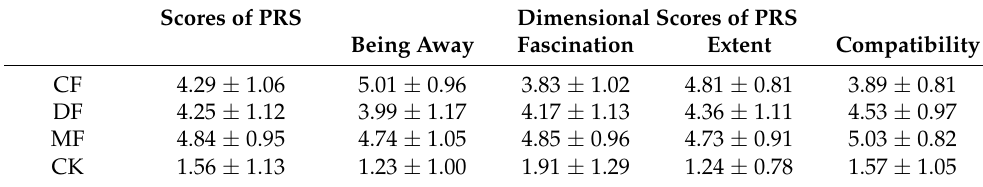
Table 2. Total and dimensional scores of PRS. Scores of PRS Dimensional Scores of PRS Being Away Fascination Extent Compatibility